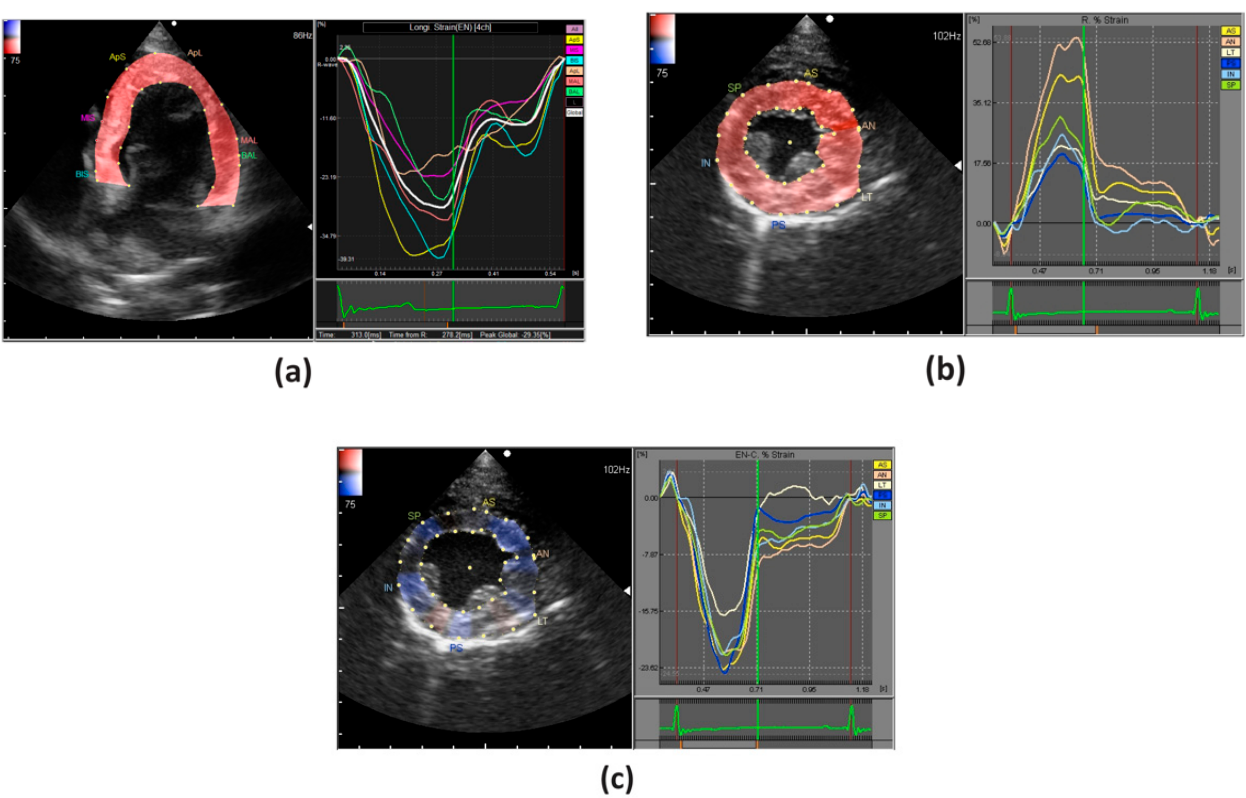
Figure 3. An example of strain analysis of the LV in a healthy dog; ( a ) longitudinal strain (apical 4-chamber view); ( b ) radial and ( c ) circumferential strains (parasternal short axis view). In longitudinal and circumferential strains, the deformation is illustrated by a negative curve during systole, whereas in radial strains it is illustrated by a positive curve.